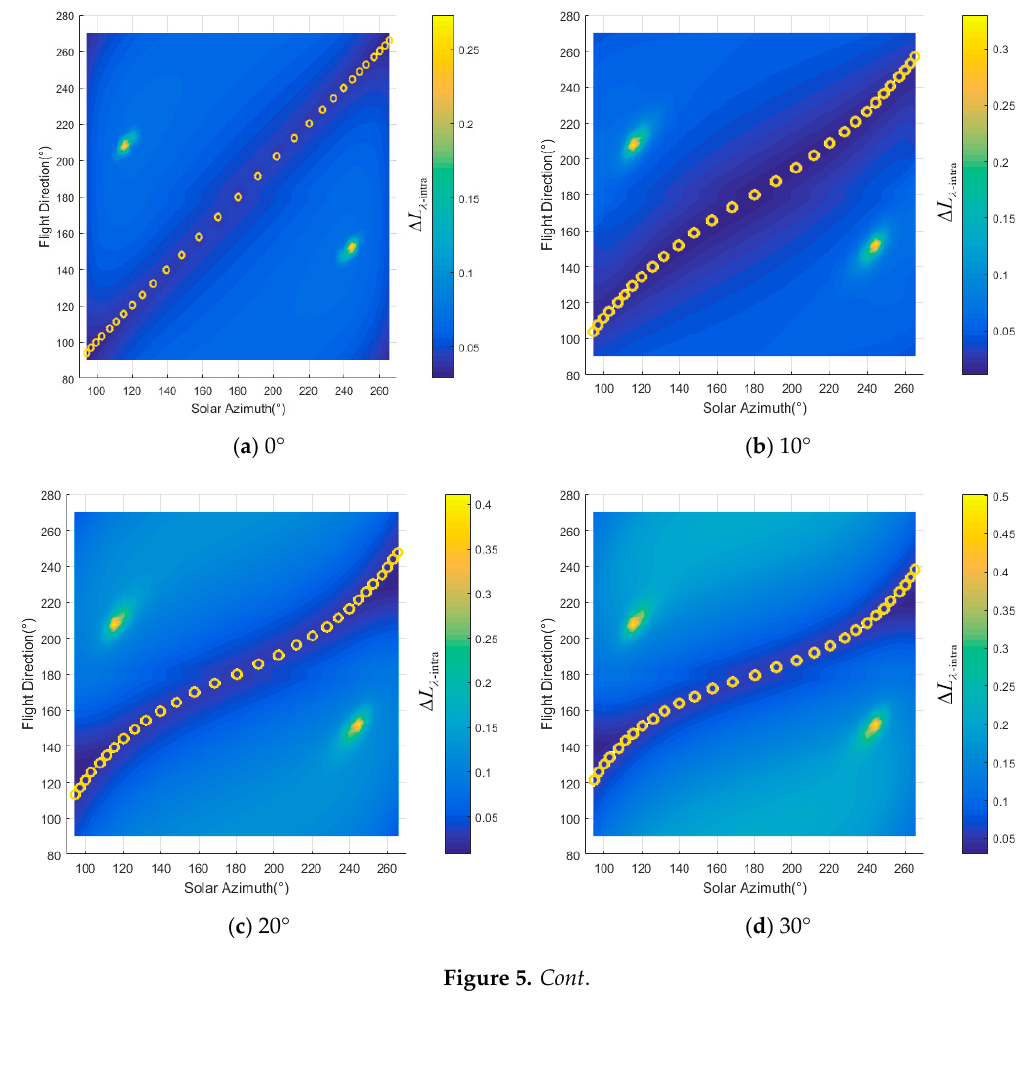
Figure 4. Radiance gradient in the image under different flight direction and solar azimuth: ( a )–( f ) the radiance gradient when aspect is 0° and slopes are 0° to 50° respectively, ( g )–( l ) the radiance gradient when aspect is 180°and slopes are 0° to 50°